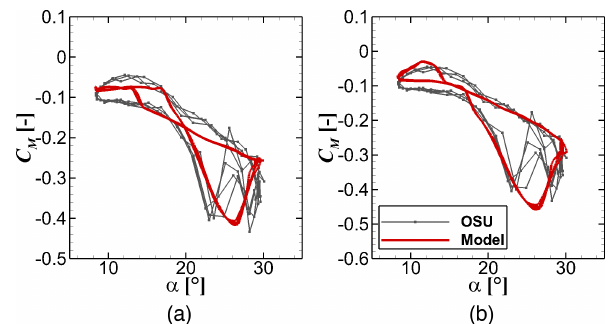
Figure 5. Moment reconstruction in comparison with the exper- imental data for the S801 airfoil (Ramsay et al., 1996) applying (a) Eq. (34) and (b) Eq.